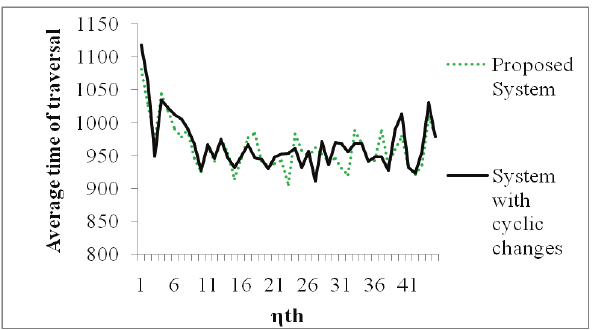
Fig. 3.Comparative analysis of traffic lights system